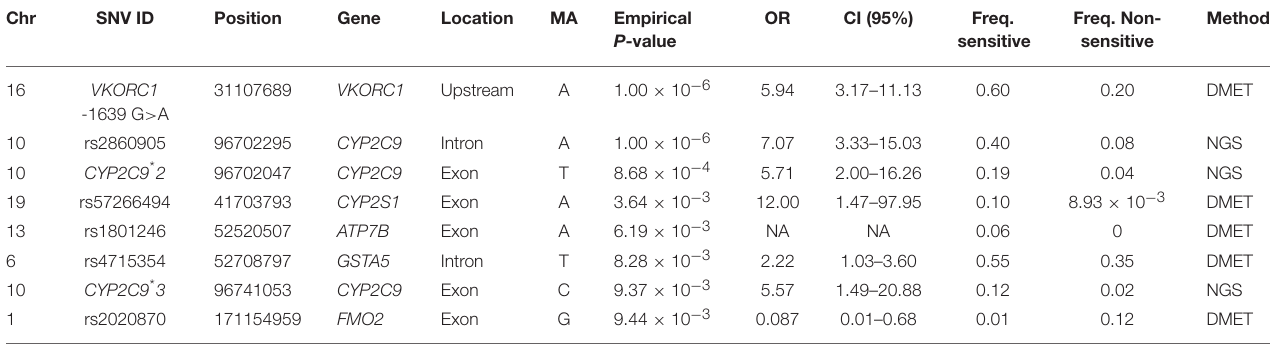
TABLE 2 | SNVs associated with warfarin sensitivity ( < 4